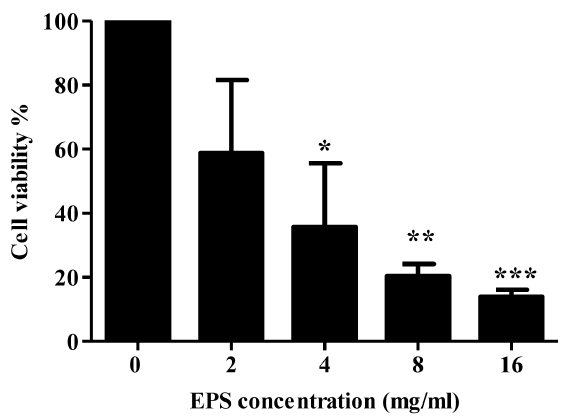
Figure 11. MOE6-EPS reduces the proliferation of MDA-MB 231 human breast cancer cells. MDA-MB 231 cells were cultured in 0, 2, 4, 8 and 16 mg MOE6-EPS/mL for 96 h and then the cell viability was assessed by the MTT assay. Values are means ± SD ( n = 3), where * p < 0.05, ** p < 0.01 and *** p < 0.001 indicate significant decreases from untreated cells.